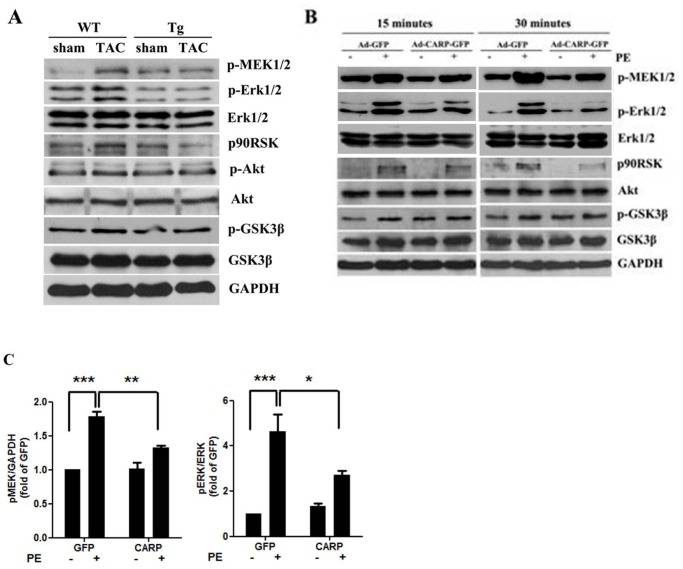
Overexpression of CARP inhibits the activation of MEK/ERK signaling by hypertrophic stimuli.(A) Western blotting of heart protein extracts to examine the levels of various phosphorylated and total kinases in WT and CARP Tg mice following TAC or a sham operation. A representative Western blot (from one of three independent experiments) is shown. (B) Western blotting of protein extracts to detect various phosphorylated and total kinase levels in parental and CARP-overexpressing cardiomyocytes subjected to phenylephrine treatment or not. A representative Western blot (from one of three independent experiments) is shown. (C) Quantification of the expression of the p-MEK1/2 and p-ERK1/2 proteins shown in (B) at 30 min after commencement of PE treatment.